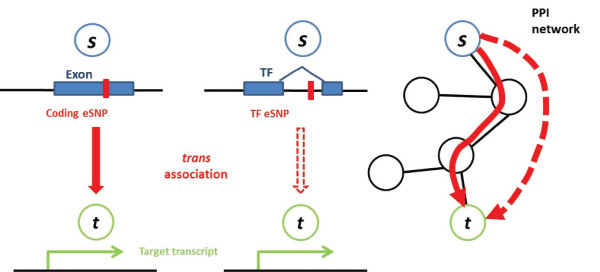
trans associations (solid and dashed red straight arrows) on a protein-protein interaction network. An eSNP (red tick mark) that resides within a known exon (left) or TF (middle) maps to the PPI network (right). The source gene (blue s) is associated in trans with the levels of a target transcript (green t). PPI network edges are denoted in black, and define the shortest path between the exon source and its target (solid red curved arrow). The association between an eSNP within a TF source and its gene target is denoted by a dashed red curved arrow. eSNP, expression single nucleotide polymorphism; PPI, protein-protein interaction; TF transcription factor.